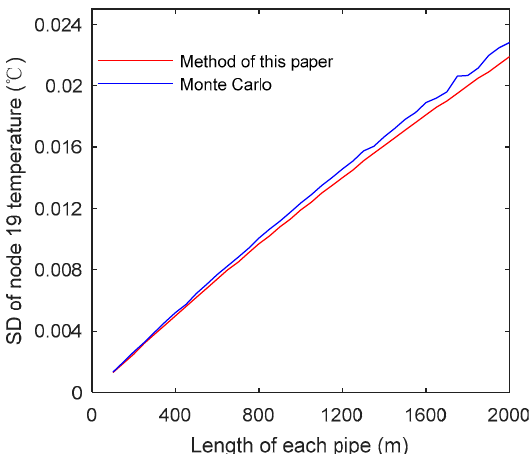
Figure 5. Relationship between the node temperature standard deviation of node 19 and pipe length (Test 4: μ ϕ = 1.0 MW ; σ ϕ = ±10%).